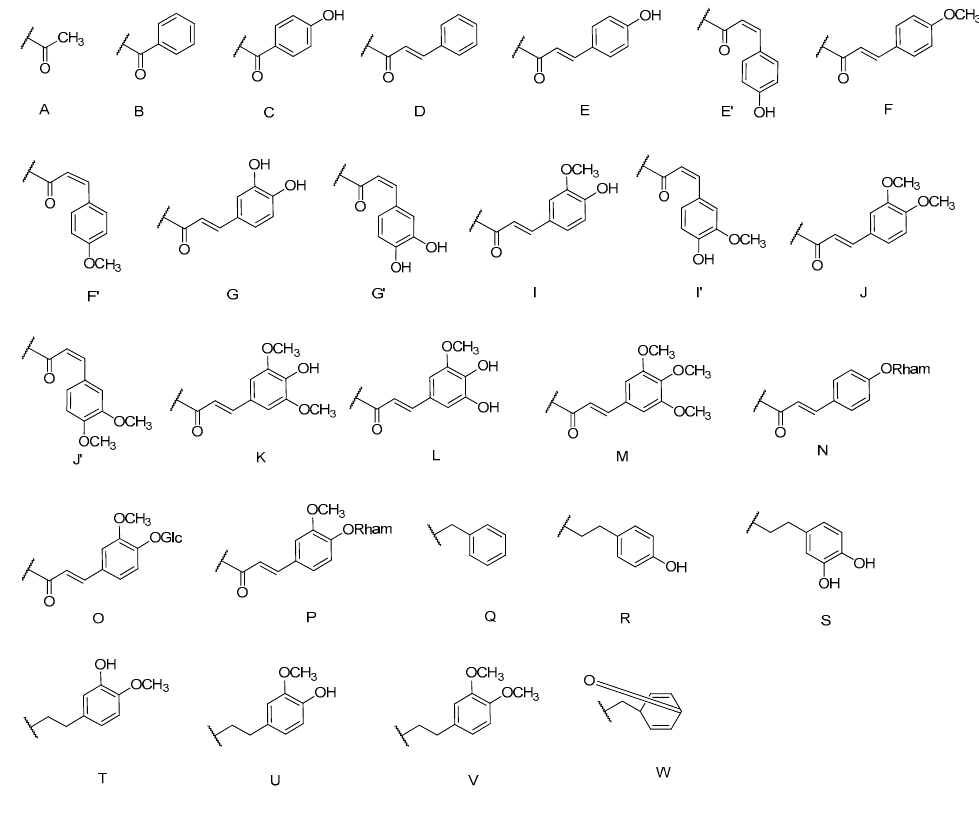
Figure 1. Substituent groups.